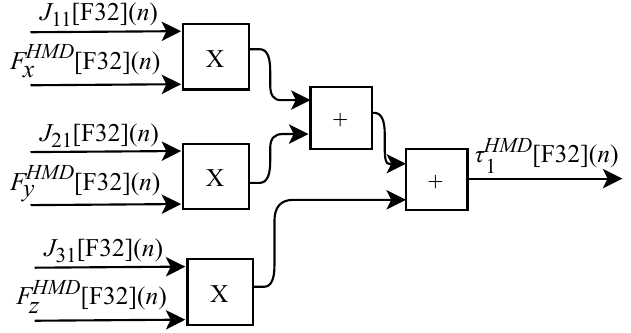
[ F 32 ]( n ) joint (Equation (39))—KFF. 1